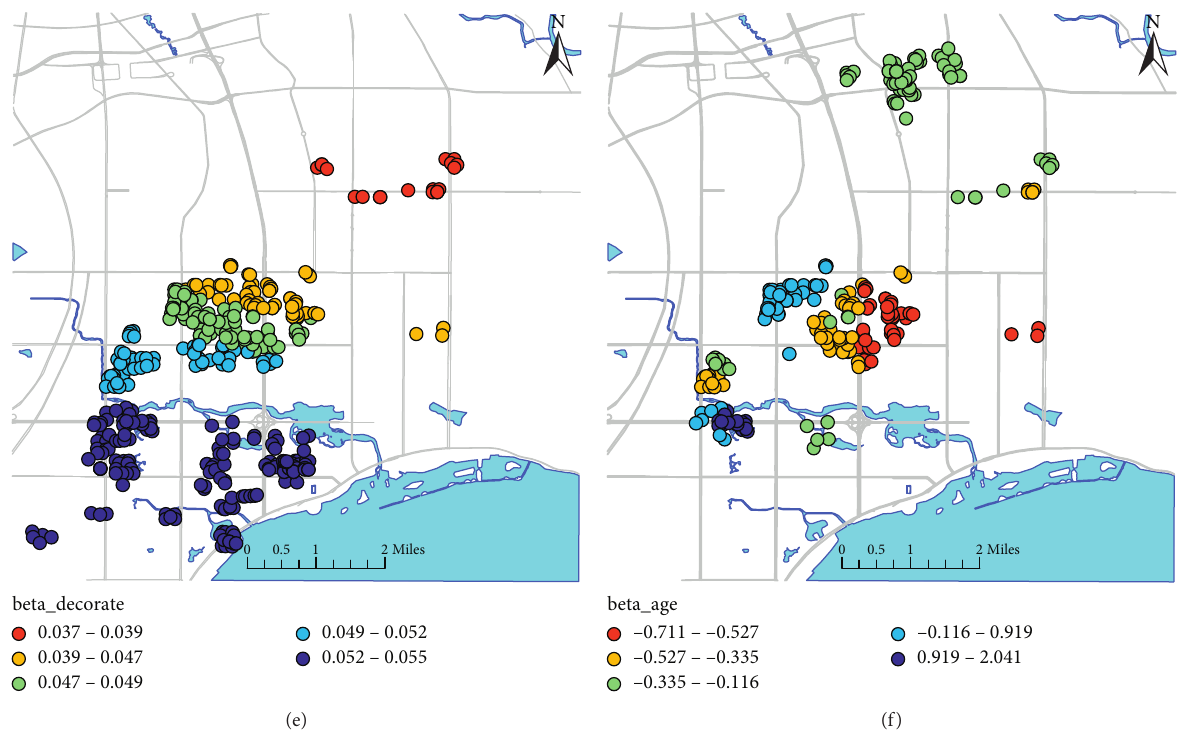
Figure 3: The spatial pattern of regression coefficients in the MGWR: (a) school, (b) bedroom, (c) orientation, (d) floor, (e) decoration, and (f)